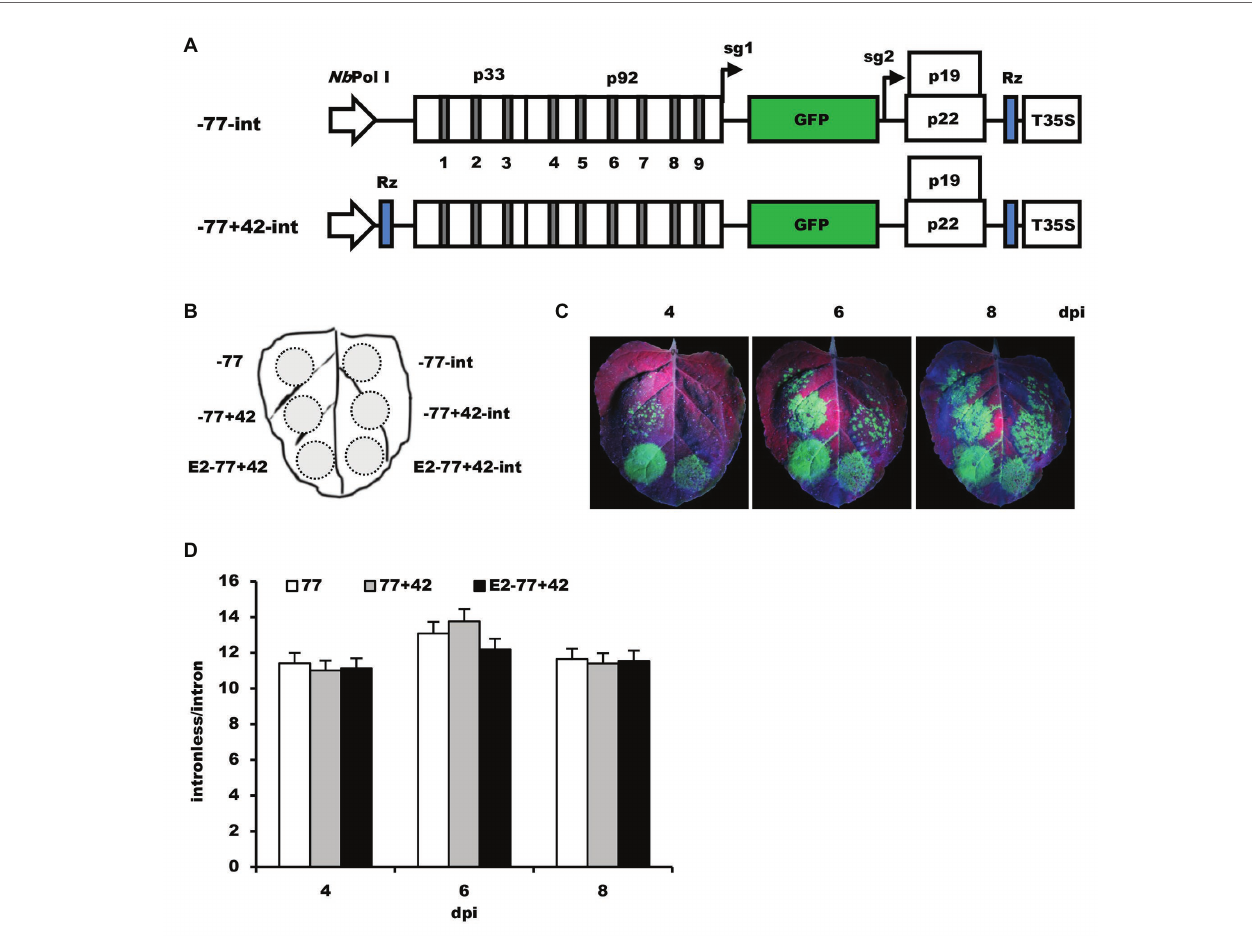
FIGURE 5 | The effects of modification of Nb rRNA gene promoter on its transcription specificity. (A) Schematic representation of the intron-containing Pol I-promoter-based TBSV vectors. -77-int, mini Nb rRNA gene promoter ( − 77)-based TBSV vector with introns; − 77+42-int, TBSV vector containing introns under control of mini Nb rRNA gene promoter ( − 77) with downstream extension sequences and a ribozyme sequence. (B) Schematic representation of the agroinfiltrated zones in N. benthamiana leaf. (C) GFP expression pattern (under UV light) of agroinfiltrated N. benthamiana leaves at 4, 6, and 8 dpi, respectively. (D) The ratios of GFP accumulation between intronless/intron-containing